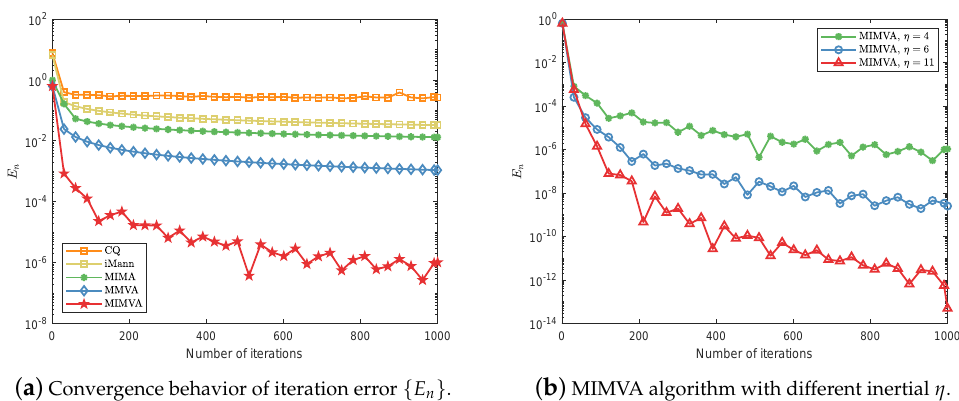
( b ) MIMVA algorithm with different inertial η . Figure 2. Numerical results for Example 2.